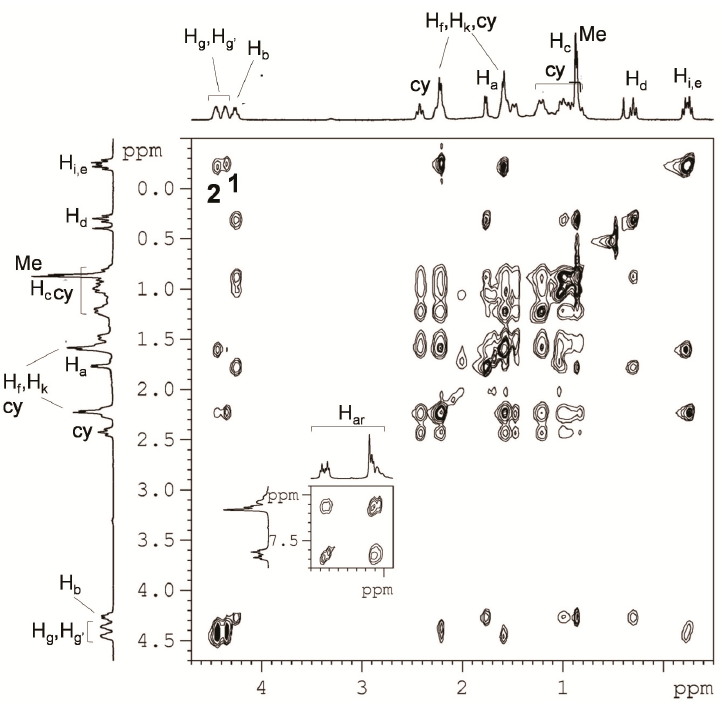
Figure 3. TOCSY NMR spectrum of ( η 3 ‐ C 4 H 7 )( η 4 ‐ C 4 H 6 )Co(PCyPh 2 ) ( 1 ).